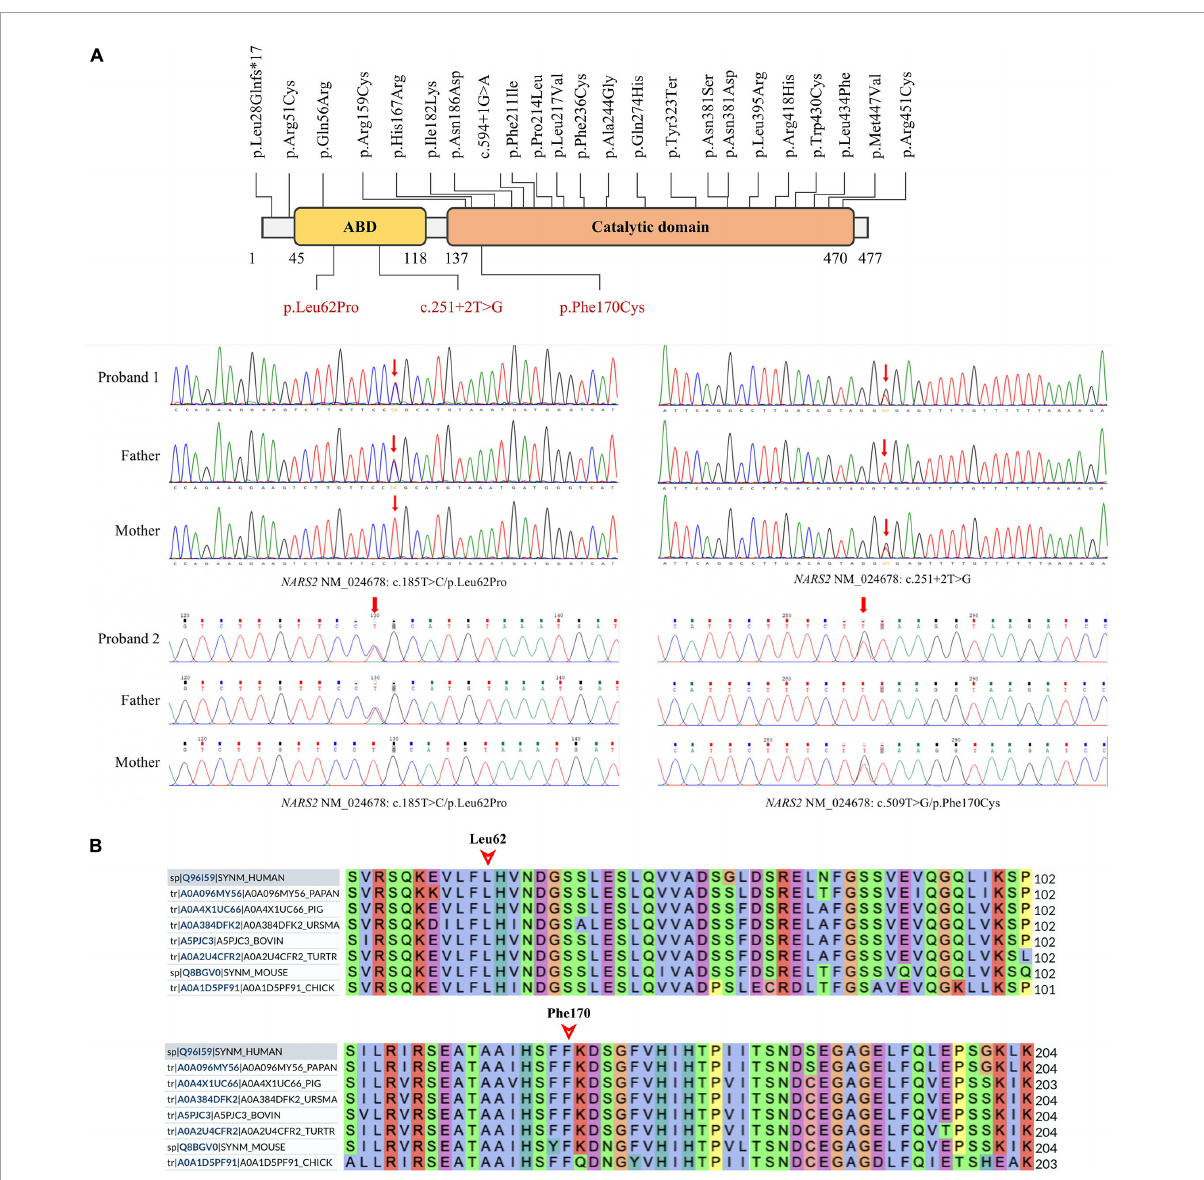
FIGURE3 NARS2 mutation information. (A) Including the three mutations in this study (red font), 26 NARS2 mutations have been reported, mainly concentrated in the categorical domain, with the highest proportion of missense mutations. NARS2 of patient #1 has compound heterozygous mutations NM_024678: c.185T > C/p.Leu62Pro and c.251 + 2T > G. The p.Leu62Pro is inherited from the father, and c.251 + 2T > G is inherited from the mother. Patient #2 also has compound heterozygous mutations NM_024678: c.185T > C/p.Leu62Pro and c.509T > G/p.Phe170Cys. The p.Leu62Pro is inherited from the father, and p.Phe170Cys is inherited from the mother. Sanger sequencing confirms the existence of mutations. (B) The homology analysis shows that Leu62 and Phe170 of the NARS2 protein are conservative among different